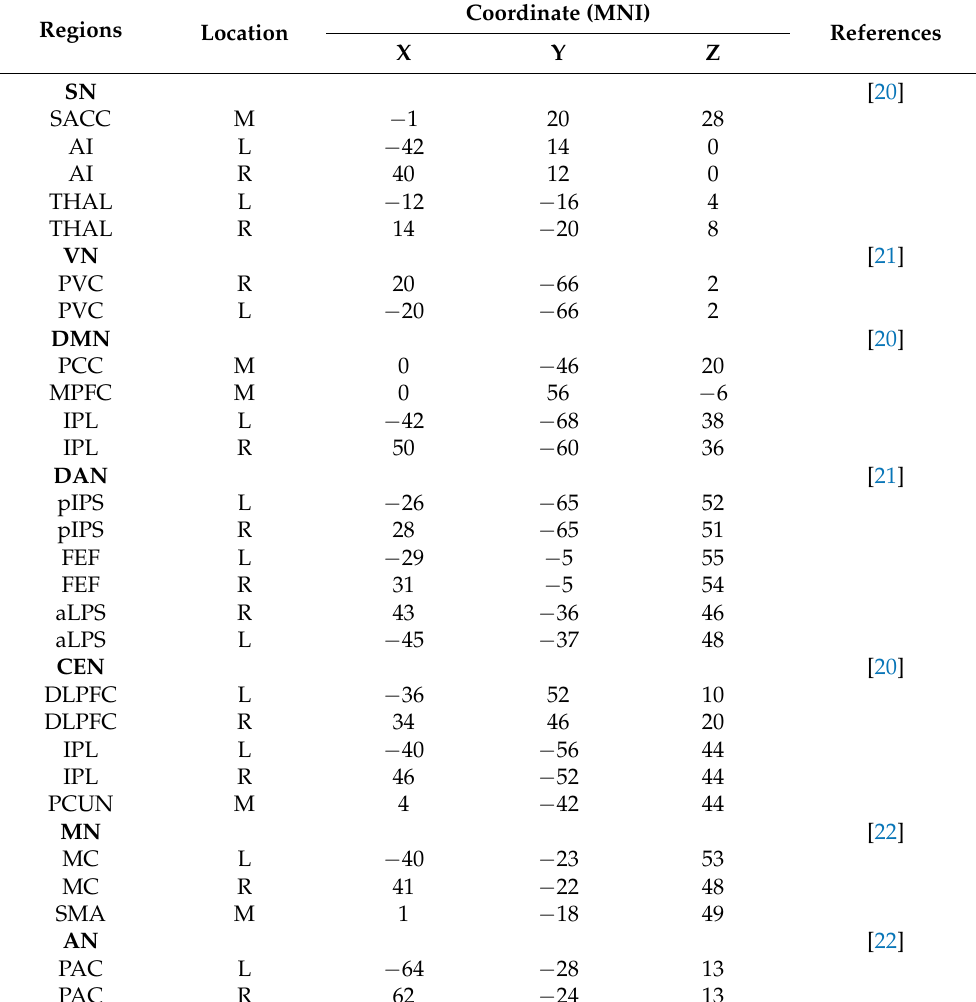
Table 1. Seed regions selected for each resting state